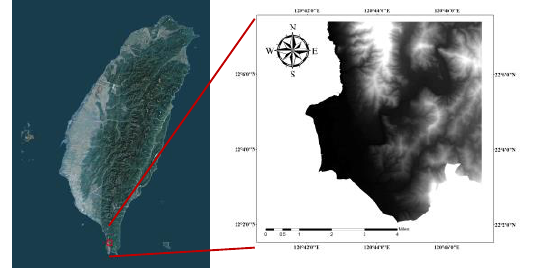
Figure 1. The study area is located in the south of